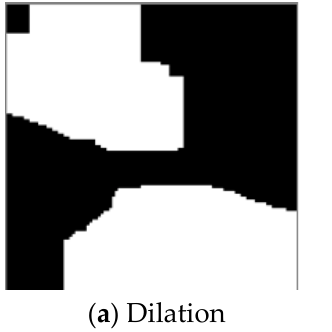
Figure 9. Edge detection effect: ( a ) grayscale process; ( b ) Gaussian blur; and ( c ) edge detection. In order to merge the effective line segments at the edge of the main body, the contour is expanded using the function cv2.dilate() , as shown in Figure 10a. As the corner of the line segment may influence the calculation process of the leave vector, i.e., the folding of the line segment may reduce the single directionality of the contour area, the function cv2.erode() is invoked to properly erode the expanded contour, as illustrated in Figure 10b.